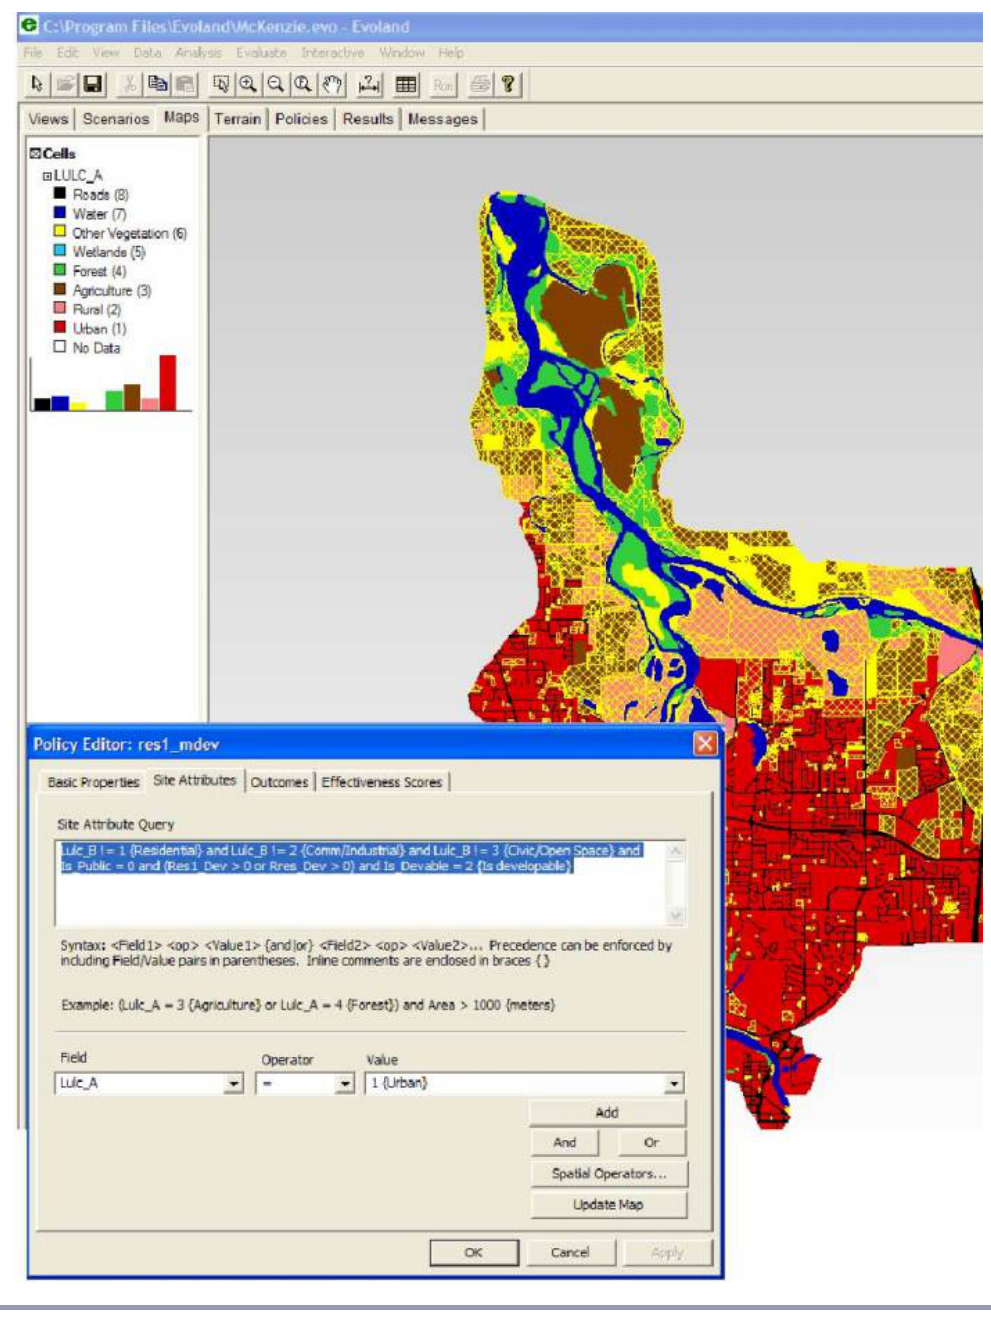
Fig. 4 . Evoland policy editor. The policy editor integrates GIS functionality and the Evoland spatial query language. The yellow-hatching in the figure shows where on the landscape the policy is admissible. In this policy, the hatching identifies rural land that is suitable for development. The yellow- hatched parcels are selected by the site attribute query, an expression similar to an SQL Select statement. The policy editor assists the analyst in writing policies in the Evoland spatial query